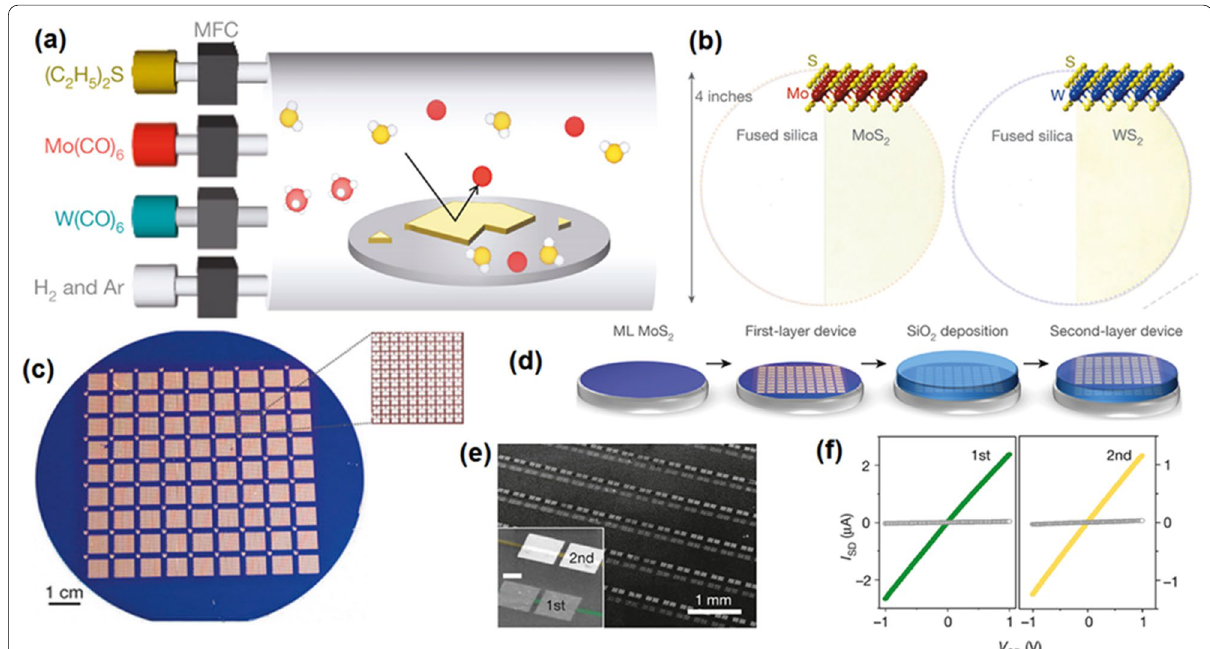
Fig. 4 Wafer-scale MOCVD growth of continues MoS 2 and WS 2 film. a The graphical schematic of CVD device and the related precursors for MOCVD of 2D MoS 2 and WS 2 films. c The batch of 8100 FET devices based on 2D MoS 2 film over Si/SiO 2 wafer. The inset shows the enlarged image of one mm square containing 100 devices. d The sequential fabrication stage of stacked MoS 2 -based device. e The image demonstrates the MoS 2 FET devices on first and second layers. f The IDS-VDS of two neighboring FET devices on two different layers. Reprinted with permission from [88]